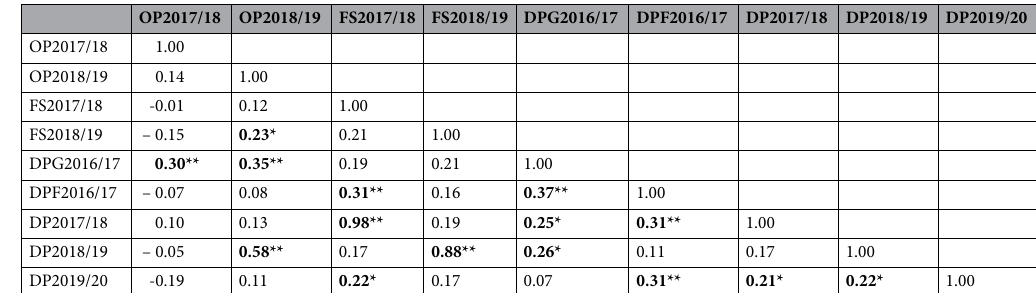
Table 2. Correlations between the dehiscence traits scored. Significant correlations are indicated in bold. Asterisks: * P ≤ 0.05; ** P ≤